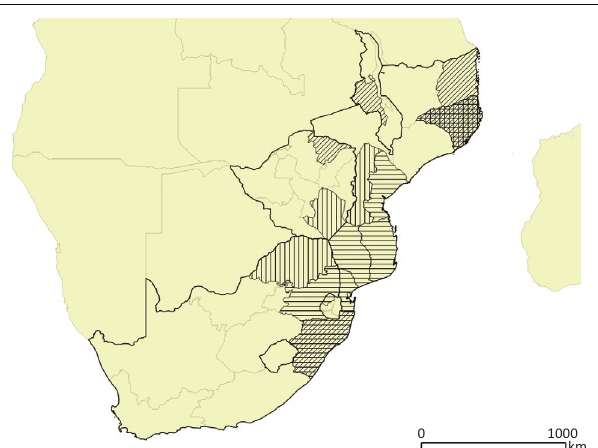
FIGURE 3: Illustrated map showing the inferred cross-border spread of endemic dog rabies between Mozambique and its neighbours. Only the provincial locations have been indicated to provide a broad overview of the samples’ locations. Samples forming part of Clade A have been indicated with horizontal lines, Clade B with diagonal lines and Clade C with vertical lines. The jackal sequence from Namibia (192J09) was not included in the map as it was only used as a root for the phylogenetic